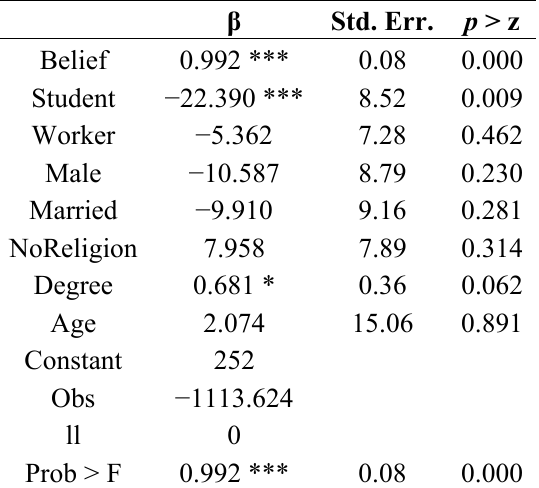
Table A11. Tobit regression (unconditional choice).